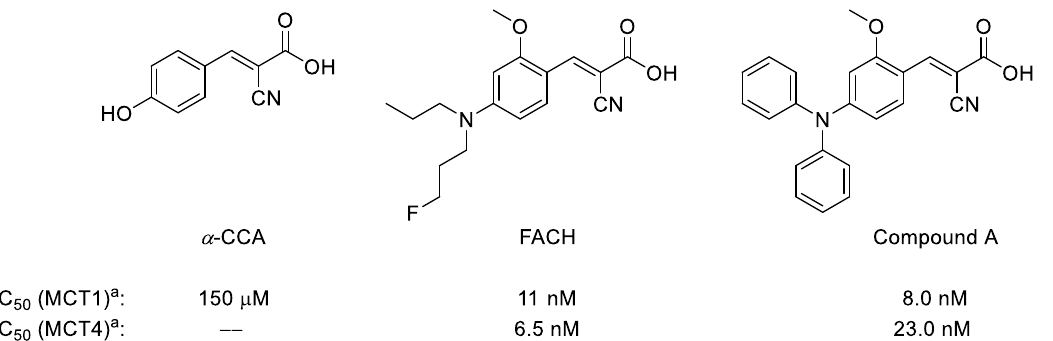
Figure 1. Chemical structures of α -CCA and its novel derivatives as potent monocarboxylate transporters 1 / 4 (MCT1 / MCT4) inhibitors; a Inhibition of [ 14 C]lactate uptake was determined in RBE4 cells (for MCT1) and in MDA-MB-231 cells (for MCT4) by measuring intracellular radioactivity after 60 min incubation without and with the respective inhibitor at 37 °C [25].